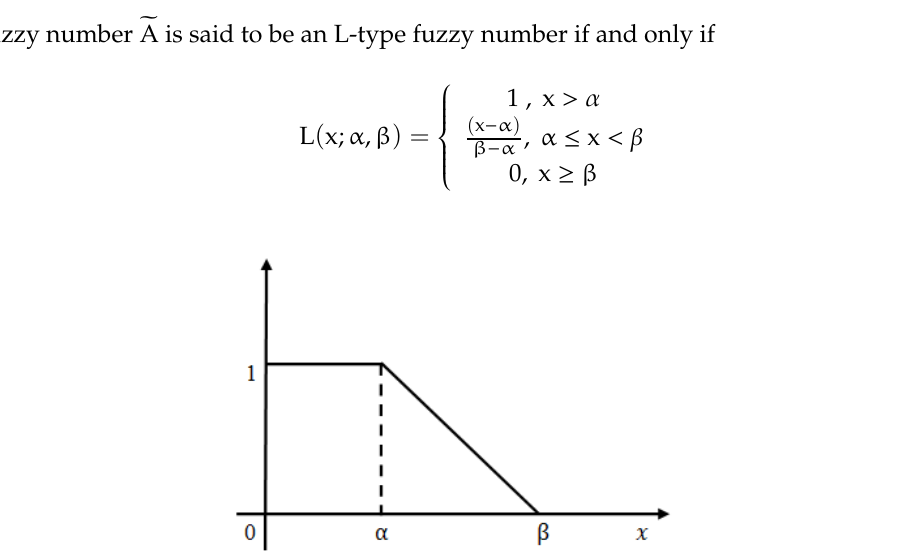
Figure 6. Graphical representation of L-Function fuzzy number.